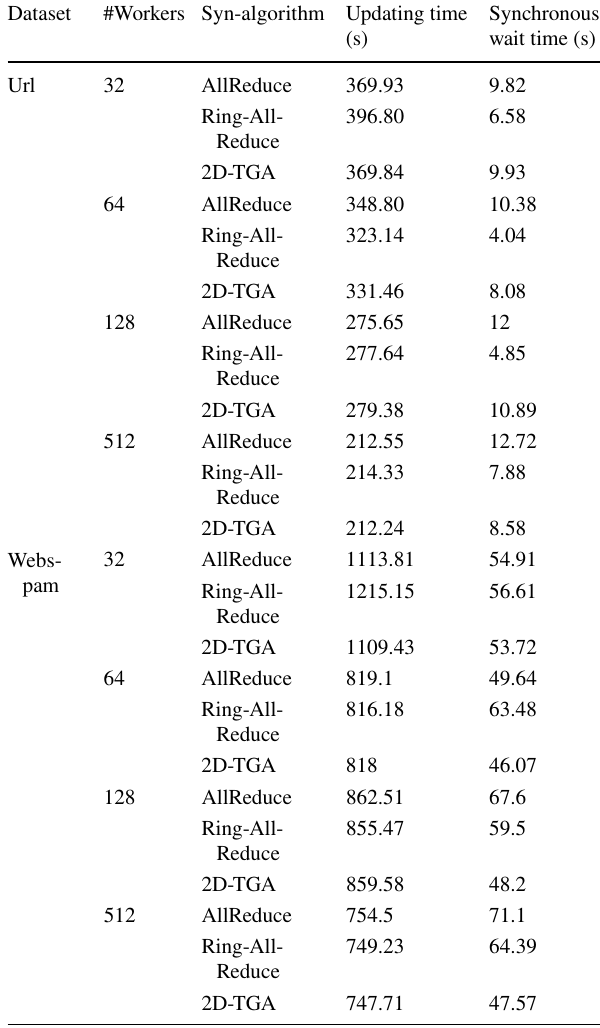
Reduce-based synchronous algorithms for different datasets Dataset # Workers Syn-algorithm Updating